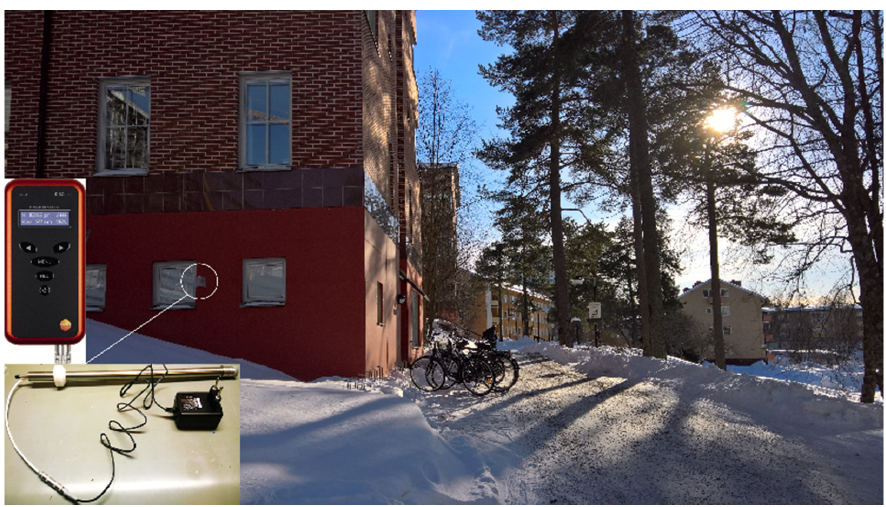
Figure 3. Measurement of nanoparticles outdoors with DISCmini. The photograph shows the measurement place, measuring device (placed indoors) and heated robe (put through the wall).